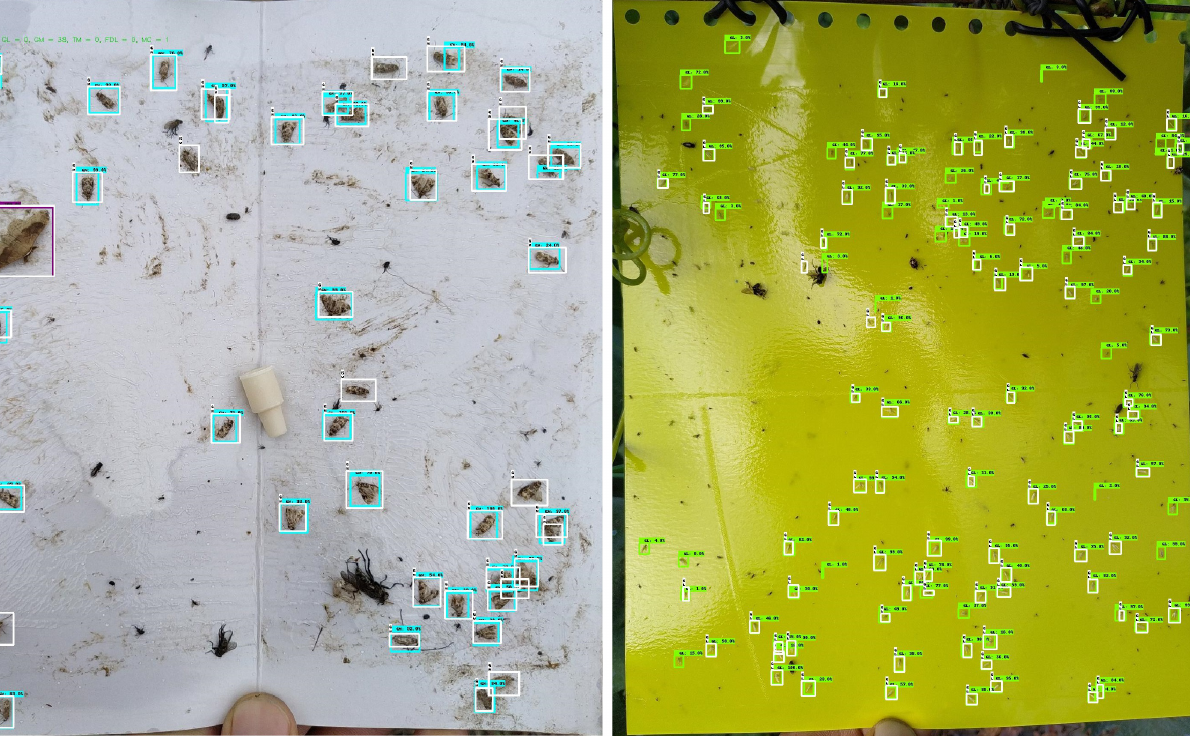
Figure 8. Examples of detections predicted by SSD ResNet50 model on delta ( left ) and sticky trap ( right ) images from the test set. The ground truth annotations are marked in white, GM predictions are in cyan, MC in purple, and GL in